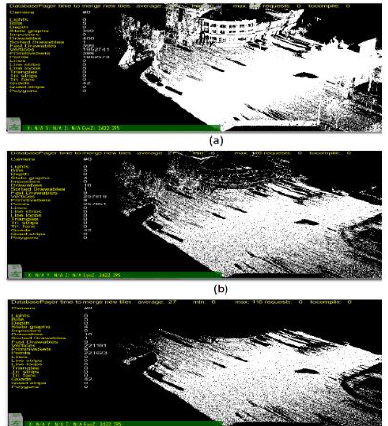
Figure 4. Mesh filtering to reduce invalid points - urban areas. Where, (a)The original 1.95 million points. (b) 0.1m cell size, getting 0.25 million lowest points. (c) 0.22 million ground points are obtained.